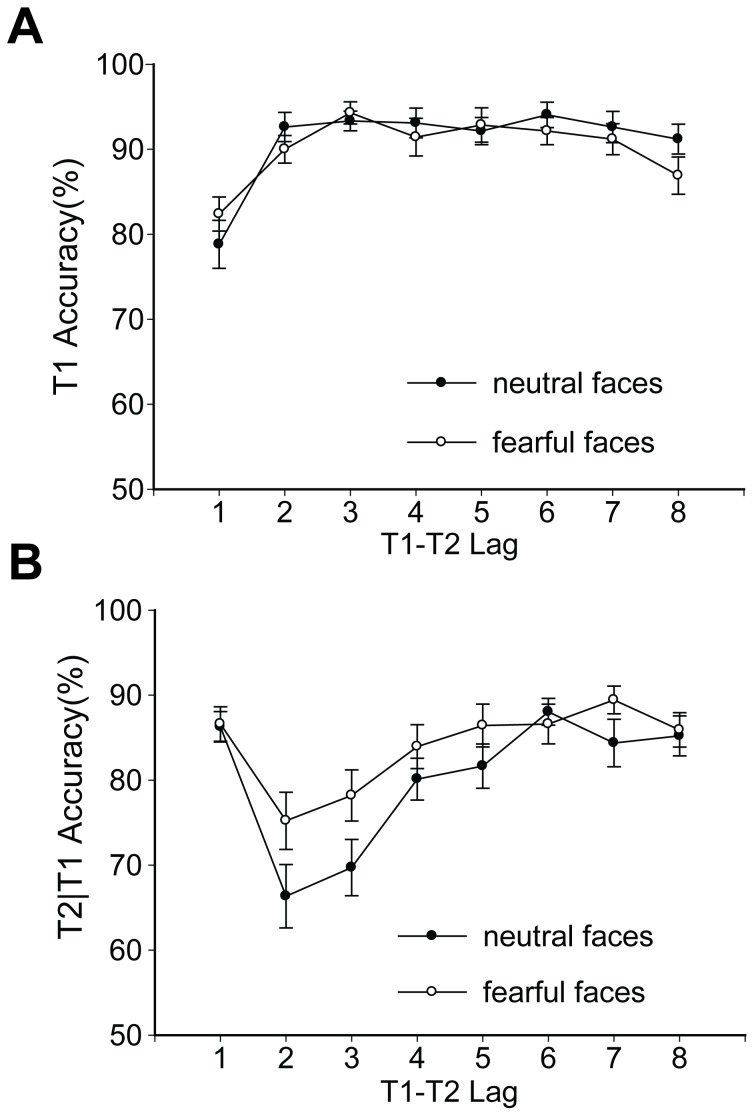
The average identification accuracy of targets in different emotional conditions of Experiment 1.(A) T1 performance; (B) T2 performance. The results are shown separately for the neutral and fearful conditions. Error bars represent one standard error of the mean.